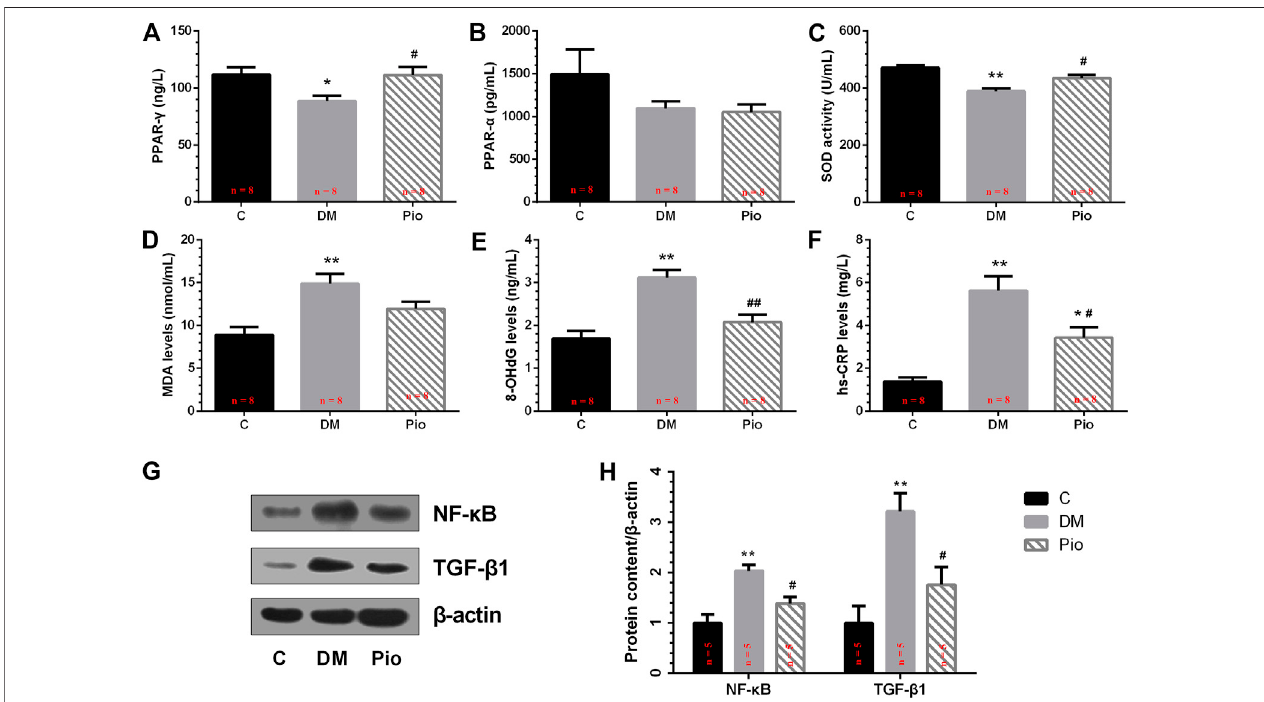
FIGURE 3 | Effects of pioglitazone on PPAR- γ , PPAR- α , and oxidative stress and in fl ammatory parameters in serum (A – F) and left atrium (G,H) . Values are presented as mean ± SEM. *Compared with the C group, p < 0.05; **compared with the C group, p < 0.01; # compared with the Diabetic group, p < 0.05; ## compared with the Diabetic group, p < 0.01. n (cid:2) 5 – 8 per group.